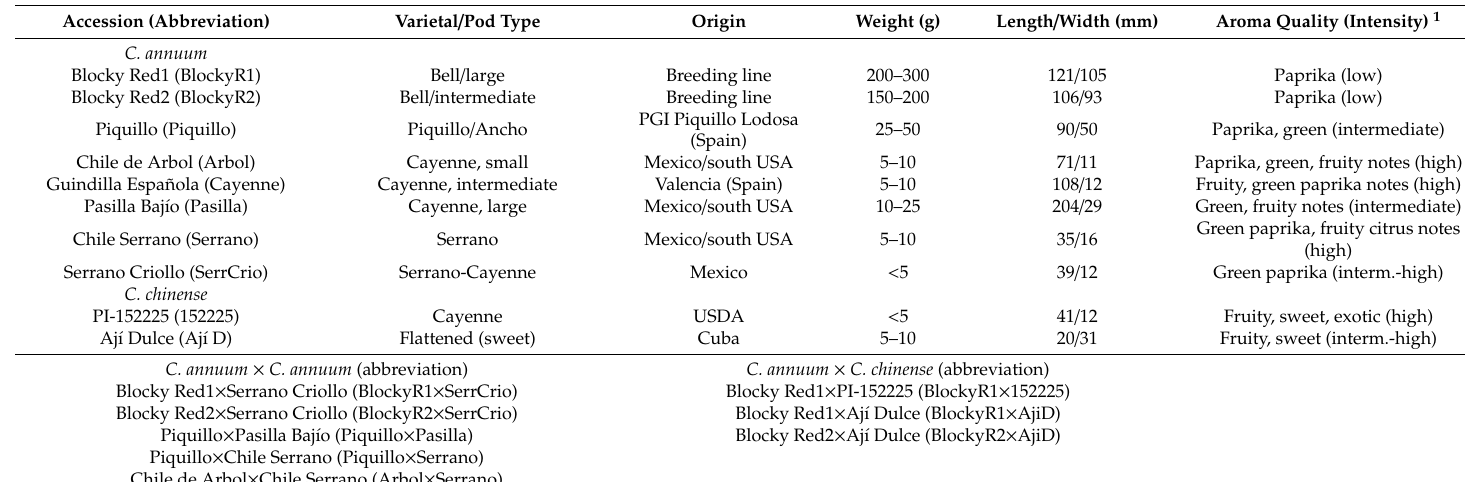
Table 1. Accession name, varietal type, origin, and fruit traits of the Capsicum parent accessions and hybrids